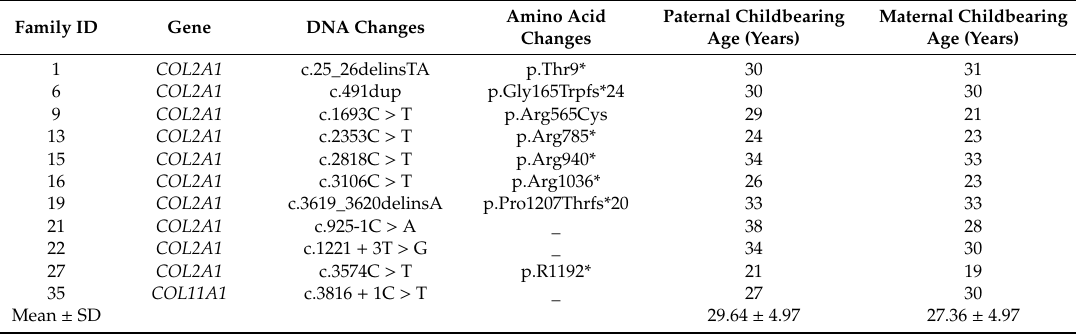
Table 3. Childbearing ages of the parents whose children had de novo